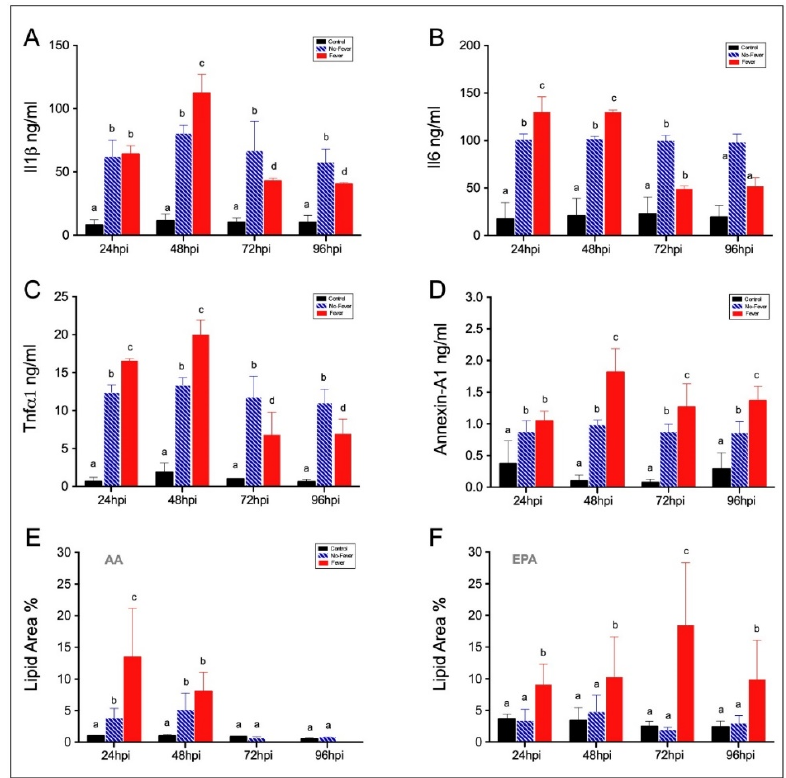
Figure 4. Indirect ELISA detection of pro- and anti-inflammatory cytokines plasmatic release and hepatic polyunsaturated fatty acids in response to IPNV challenge. ( A – D ) Bar graphs showing the expression of Il1β ( A ) , Il6 ( B ) , Tnfαr ( C ) , and annexin-1A ( D ) proteins between groups subjected to thermal gradients. The differences between control (uninfected individuals, black bars), no-fever (dashed blue bars), and fever (red bars) fish are shown (mean ± SD, two-way ANOVA followed by Tukey’s post hoc test, p < 0.0001). Different letters denote significant differences. ( E ) Arachidonic acid (AA) and ( F ) eicosapentaenoic acid (EPA) hepatic profiles (% of total fatty acid identified in the liver) in fish after IPNV infection. Bar graphs showing the differences between control (uninfected fish, black bars), no-fever (dashed blue bars), and fever (red bars) individuals. Different letters represent significant differences (mean ± SD, two-way ANOVA followed by Tukey’s post hoc test, p < 0.05). The cytokine ELISA assay is described in the Supplementary Materials section. ng/mL: nanograms per millilitre; hpi: hours post-infection; SD: standard